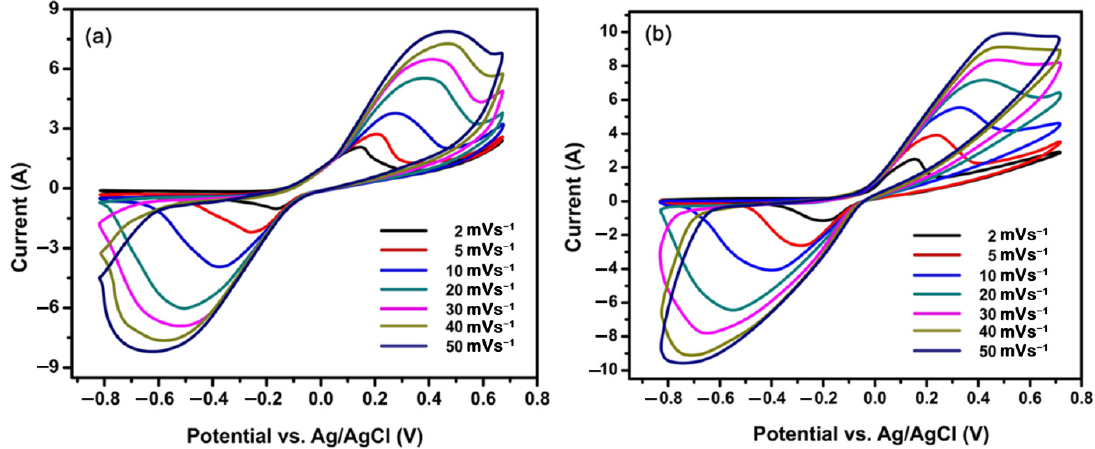
Figure 5. CVs measured of ( a ) PANI:PPy/AC and ( b ) PANI:PEDOT/AC in 2 M KCl.